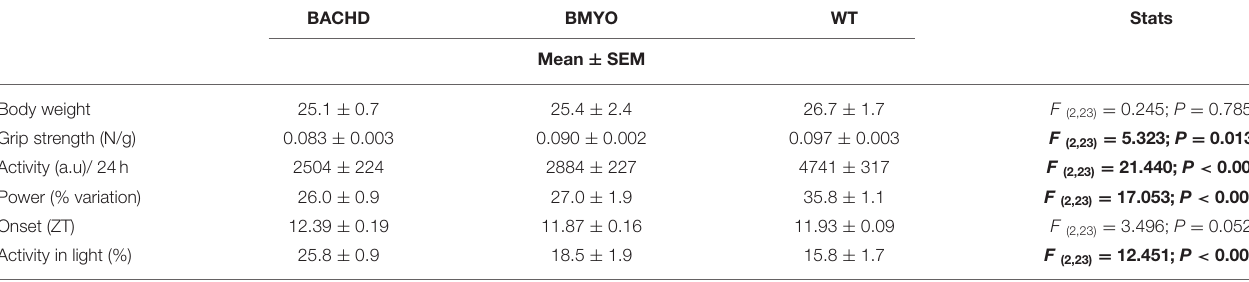
TABLE 5 | Behavioral measurements of motor function from BACHD, BMYO and WT animals at 6 months of age. BACHD BMYO WT Stats Mean ± SEM Body weight 25.1 ± 0.7 25.4 ± 2.4 26.7 ± 1.7 F (2,23) = 0.245; P =